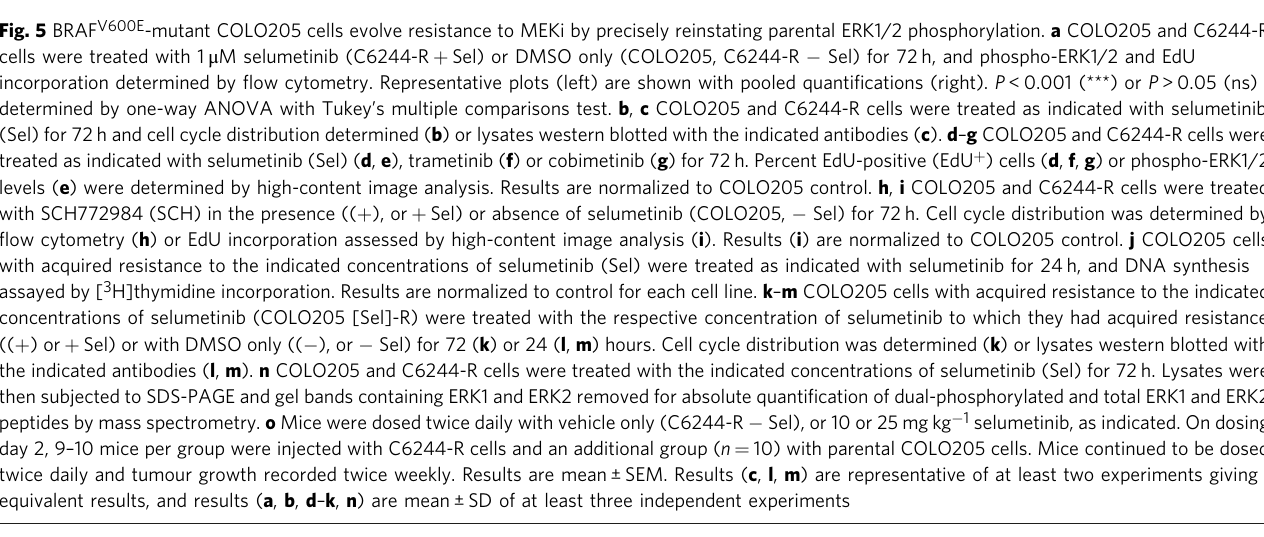
Fig. 5 BRAF V600E -mutant COLO205 cells evolve resistance to MEKi by precisely reinstating parental ERK1/2 phosphorylation. a COLO205 and C6244-R cells were treated with 1 μ M selumetinib (C6244-R + Sel) or DMSO only (COLO205, C6244-R − Sel) for 72 h, and phospho-ERK1/2 and EdU incorporation determined by fl ow cytometry. Representative plots (left) are shown with pooled quanti fi cations (right). P < 0.001 (***) or P > 0.05 (ns) determined by one-way ANOVA with Tukey ’ s multiple comparisons test. b , c COLO205 and C6244-R cells were treated as indicated with selumetinib (Sel) for 72 h and cell cycle distribution determined ( b ) or lysates western blotted with the indicated antibodies ( c ). d – g COLO205 and C6244-R cells